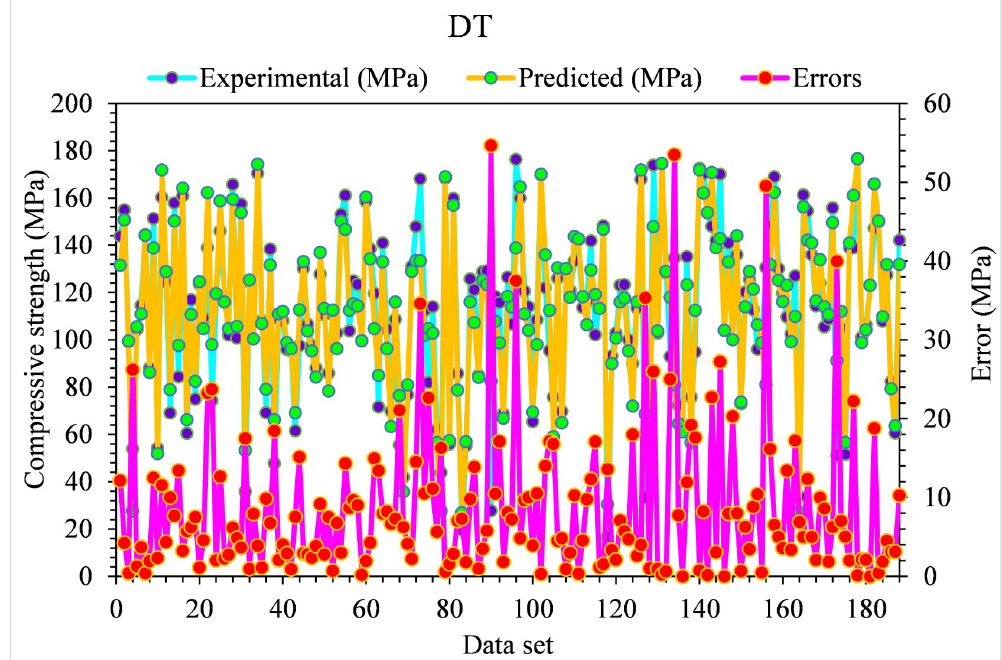
Fig 7. DT predicted and experimental error values–UHPC compressive strength.